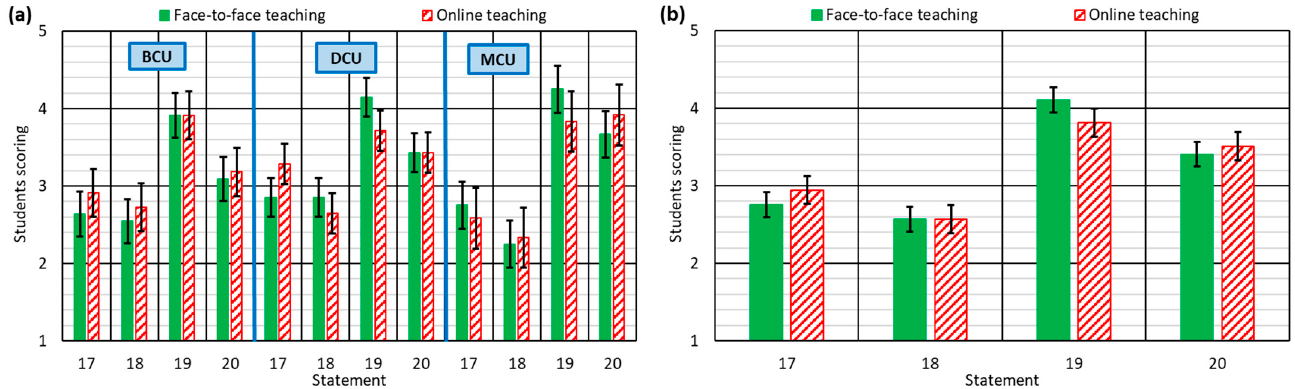
Figure 6. Student responses to statements 17–20: ( a ) for each type of course unit; ( b ) for all course units.